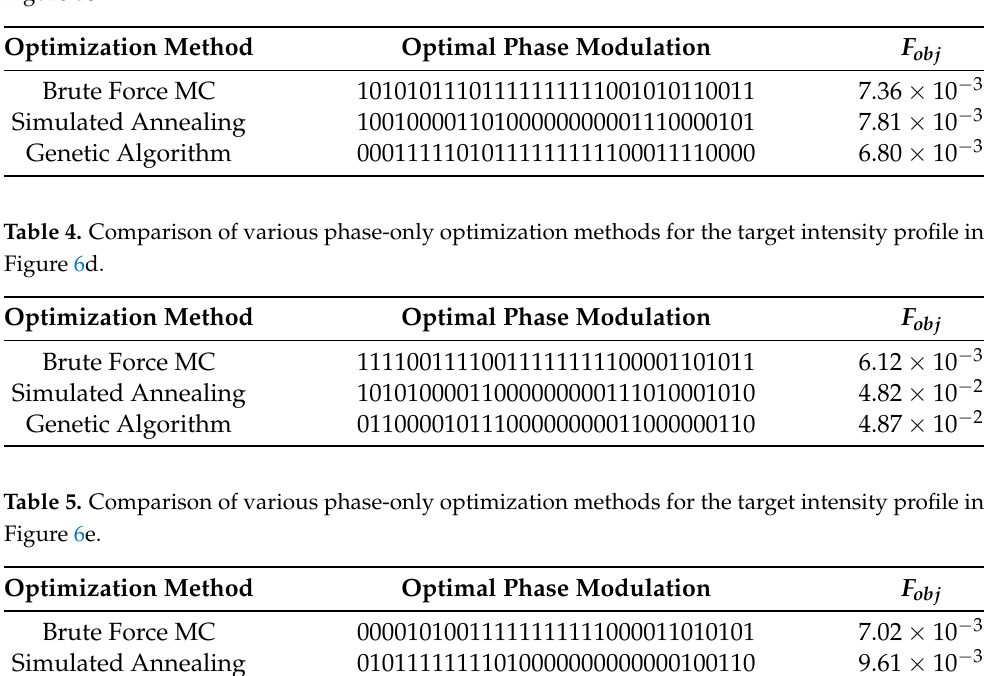
Table 3. Comparison of various phase-only optimization methods for the target intensity profile in Figure 6c.